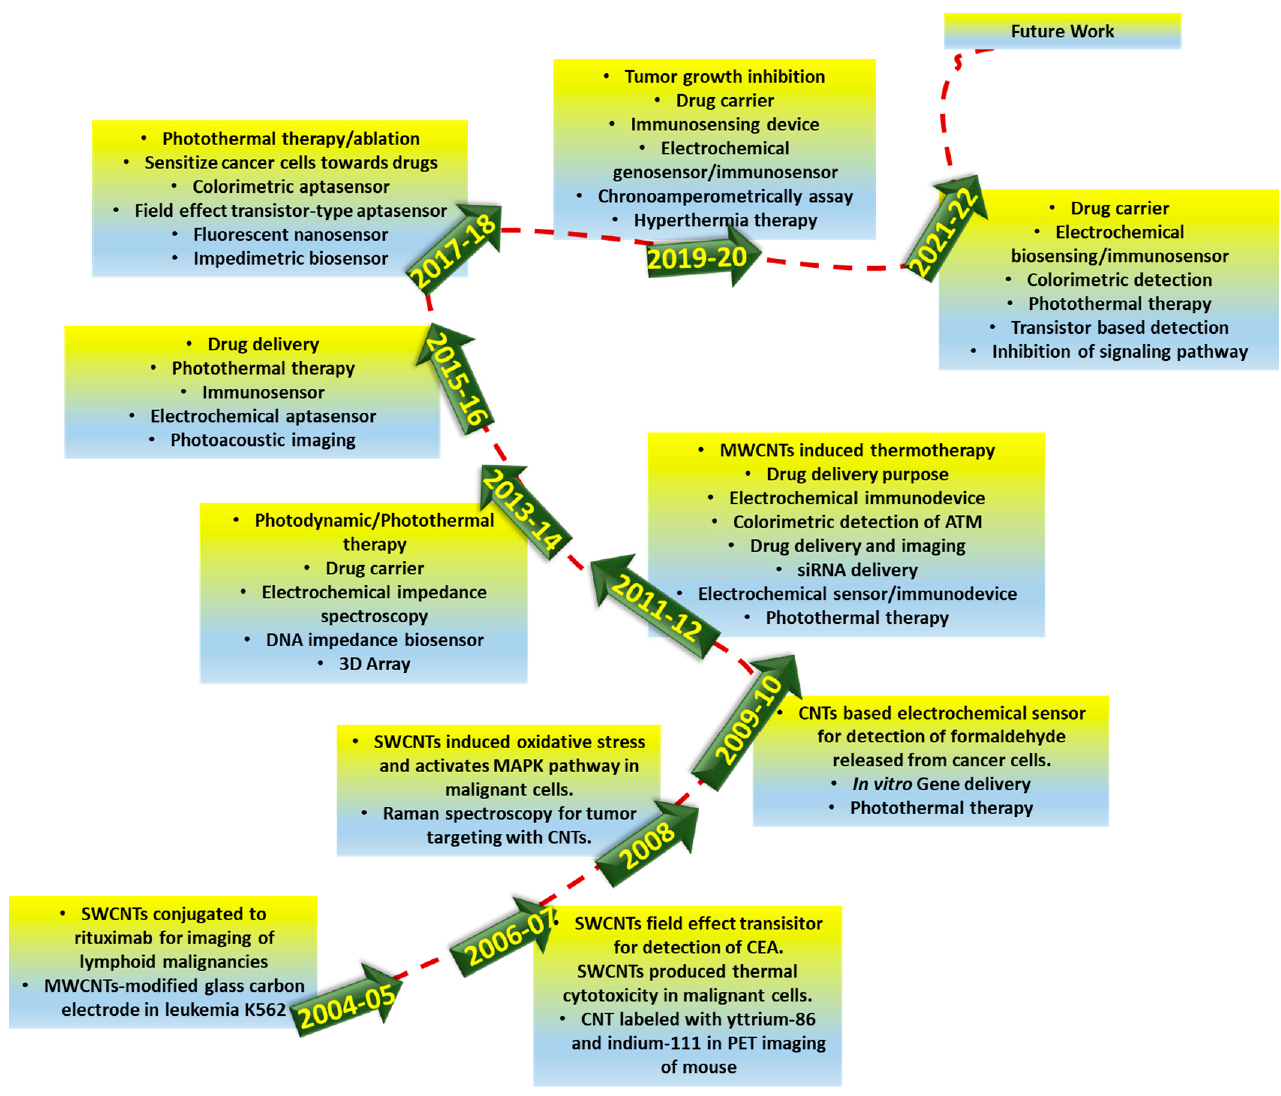
Figure 3. A roadmap for the evolution in the use of carbon nanotubes in cancer targeting and diag- nosis.